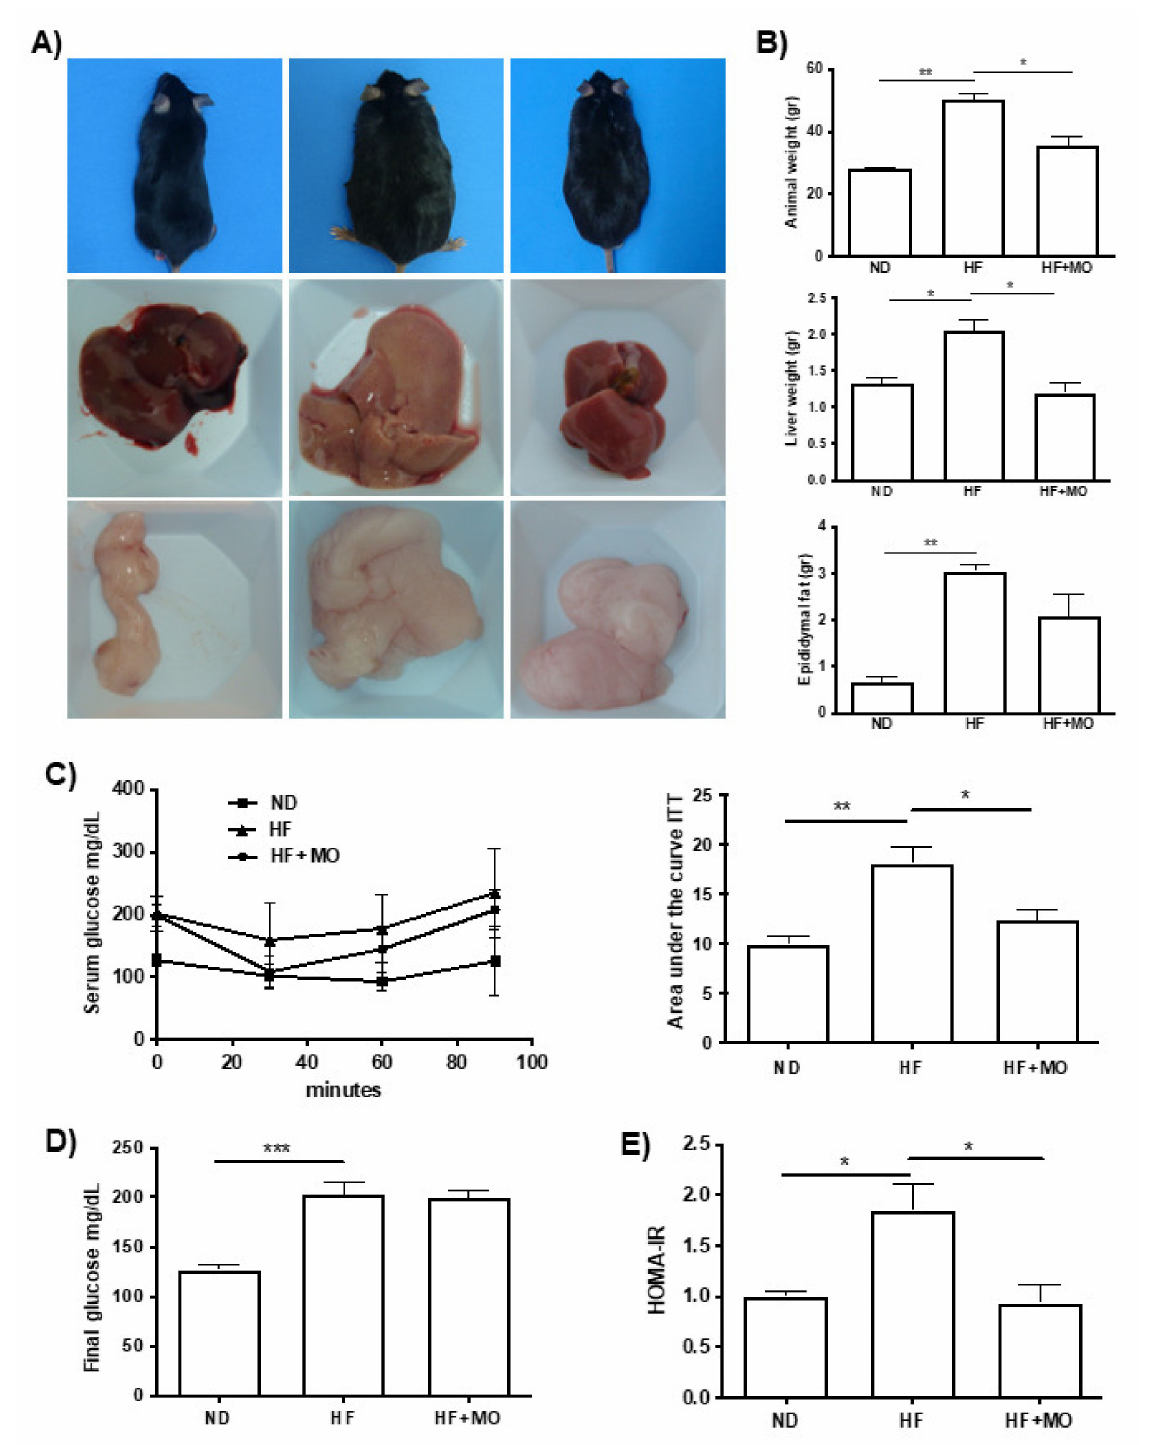
Figure 1. Moringa diminished animal, liver and epididymal fat weight and maintained insulin sensi- tivity in animals feed with HF diet. ( A ) Representative photographs of mice, liver and epididymal fat. ( B ) Graphs of animal, liver and epididymal fat weight showed a reduction in MO group ( p < 0.05). ( C ) ITT demonstrated a significant improvement in insulin sensitivity in MO group compared to HF animals ( p < 0.05). ( D ) Serum glucose levels at sacrifice were similar in MO and HF groups. ( E ) HOMA-IR showed insulin resistance in present only in HF animals ( p < 0.05). Data are expressed as mean ± SE. * p < 0.05; ** p < 0.01; *** p <